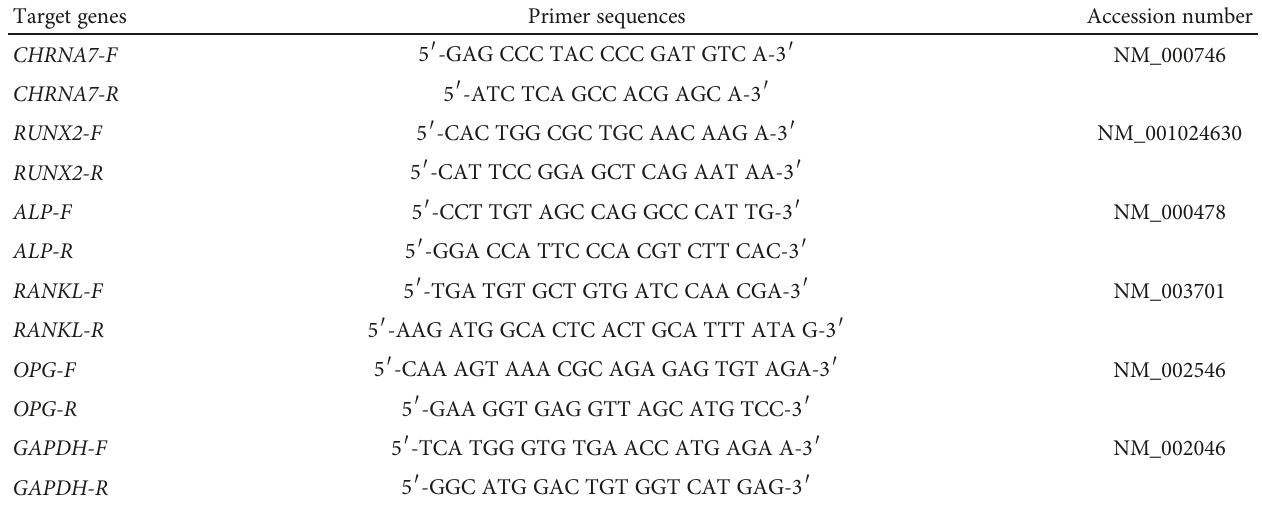
Table 1: The qRT-PCR primer